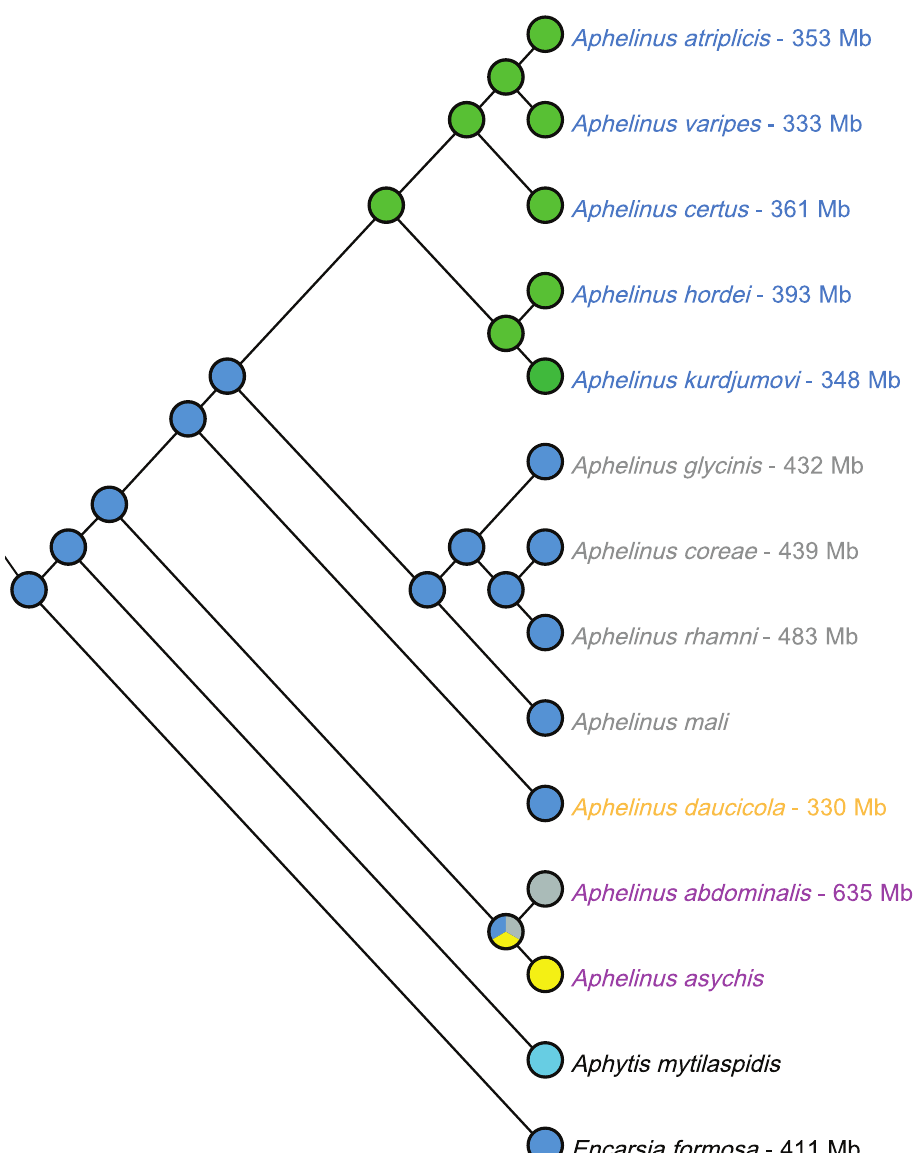
Figure 5. Chromosomal formulae and genome sizes on phylogeny of Aphelinus species and several out- groups. Blue = 5 metacentric chromosomes; aqua = 1 metacentric and 4 acrocentric chromosomes; green = 2 metacentric and 2 acrocentric chromosomes; dark green = 1 metacentric and 3 acrocentric chromo- somes; yellow = 2 metacentric, 1 subtelocentric, and 1 acrocentric chromosome; grey = unknown. Num- bers after species names are genome sizes estimated from flow cytometry; values for Aphelinus abdominalis and E. formosa are from (Ardila-Garcia et al. 2010). The different colors for species of Aphelinus indicate membership in the four species complexes for which data are